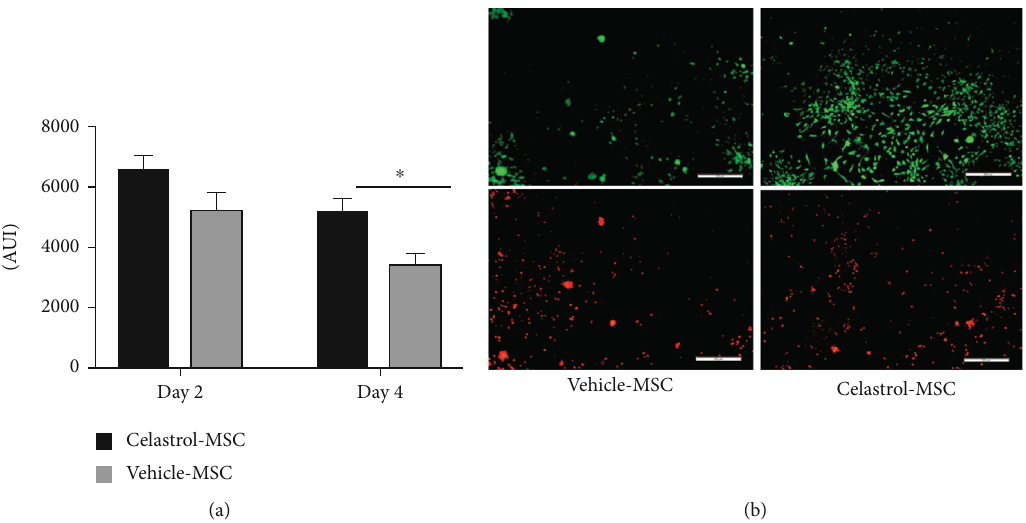
Figure 3: Celastrol increases the viability of encapsulated MSC in low serum media: (a) metabolic activity, at days 2 and 4, of hMSC pretreated with 1 μ M of celastrol or vehicle (DMSO 0.1% v / v ), encapsulated in 200 μ L of hydrogel, and incubated in low serum media; mean ± SEM , n = 7 , N = 3 ( ∗ p < 0 : 05 versus the vehicle at each time point); (b) live/dead pictures taken at day 4 (viable cells: green, dead cells: red; scale bar = 200 μ m).